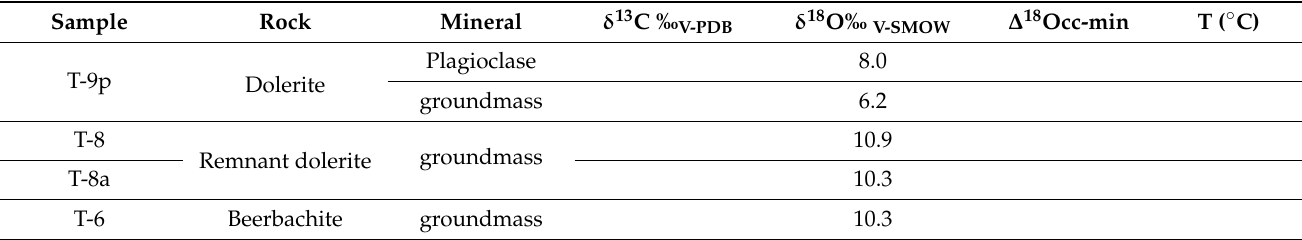
Table 1. Oxygen and carbon isotope compositions in minerals from the Tazheran rocks and marbles.